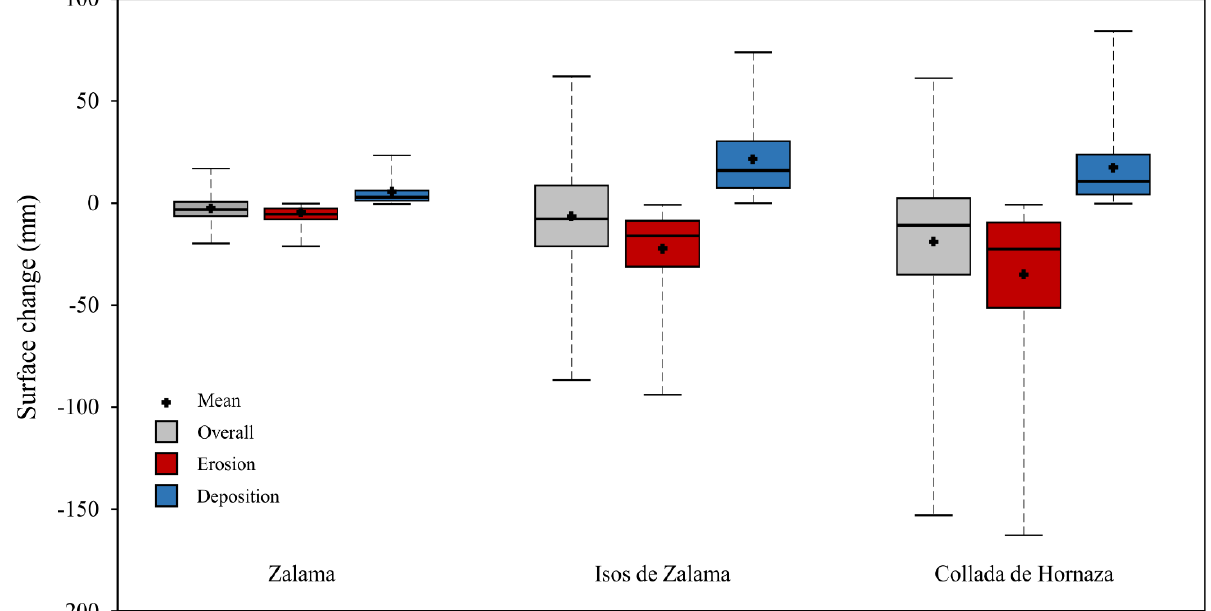
Figure 4. Distribution of surface change values for Zalama, Ilsos de Zalama and Collado de Hornaza showing 1 %, 25 %, 50 %, 75 % and 99 %